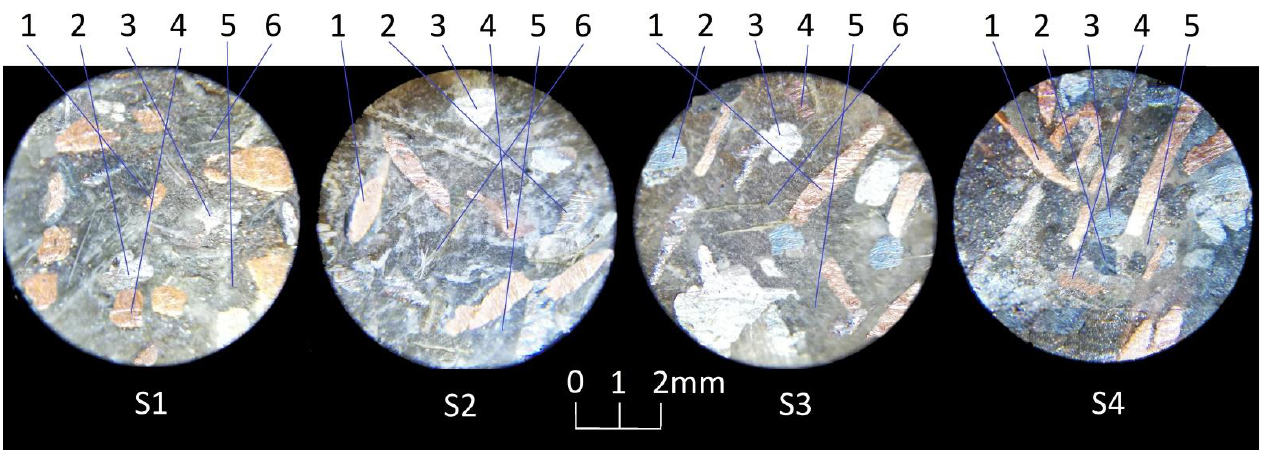
Figure 3. Micrograph of the surface of samples from each group: 1 — copper, 2 — cast iron, 3 — steel, 4 — brass, 5 — matrix (resin with graphite and ash), 6 — aramid.